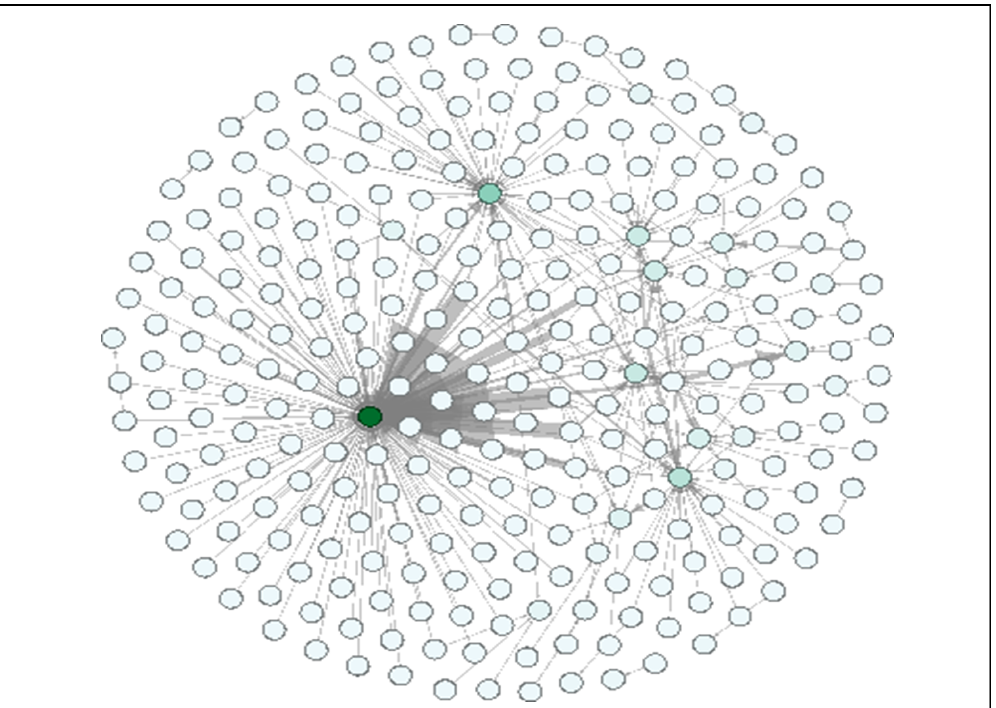
Figure 7. Publication title network map and citations received by publications (Source: https: //gephi.org/ (accessed on 21 December 2020)).